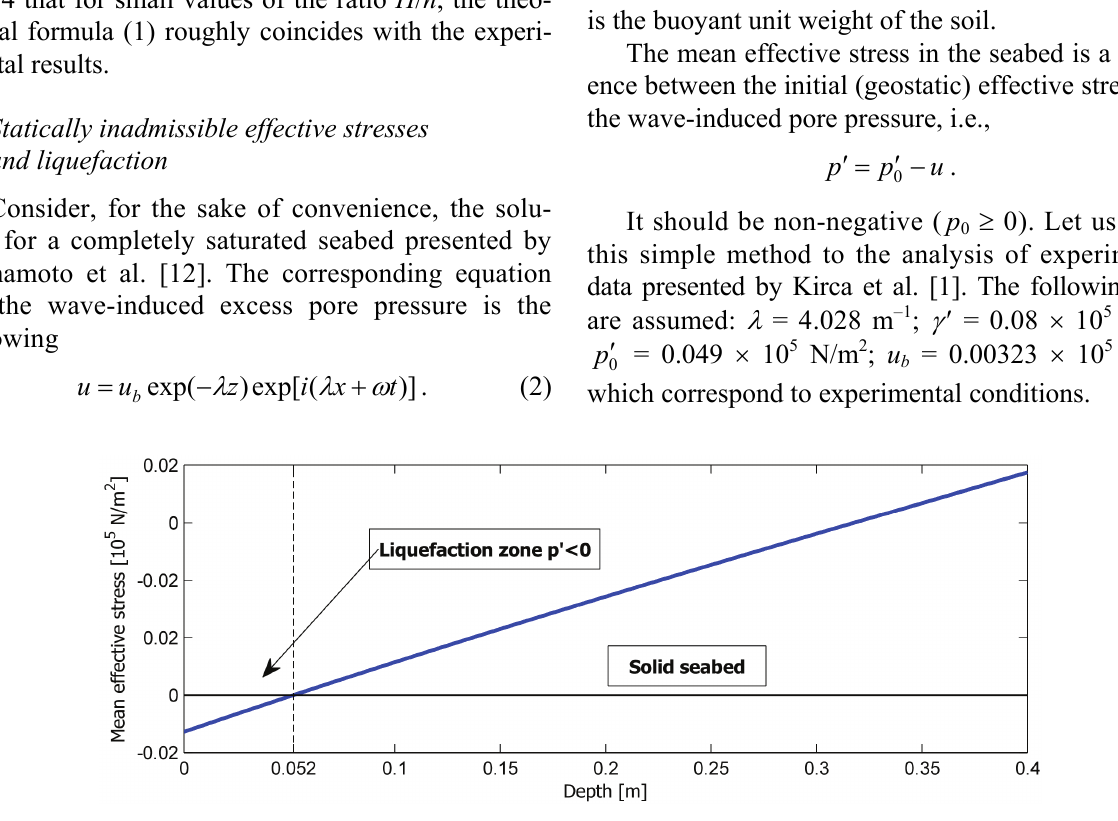
Fig. 5. Distribution of the mean effective stress for the experiments of Kirca et al. [1], according to the Biot-type